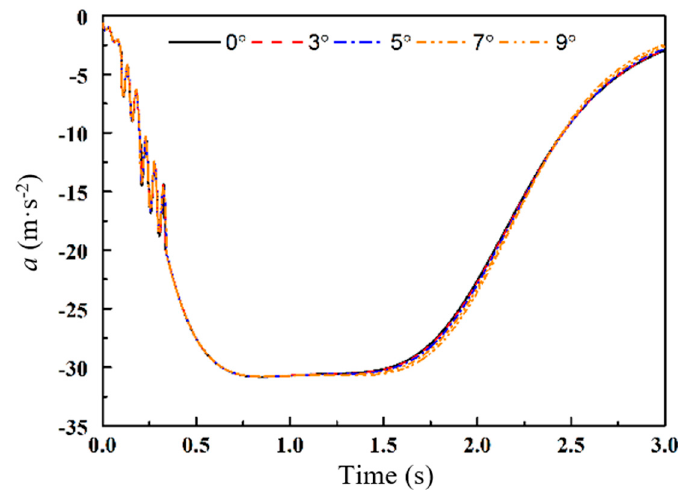
Figure 16. Velocity–time.